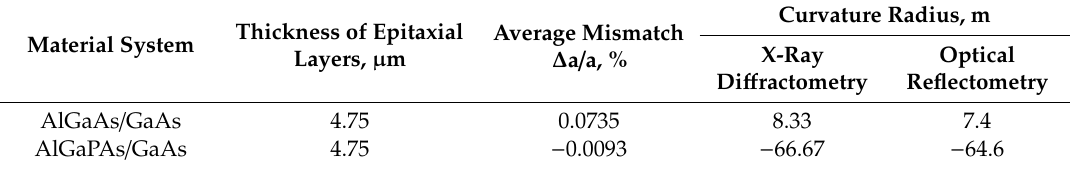
Table 2. Dependence of the curvature radius on the material system and total lattice mismatch.